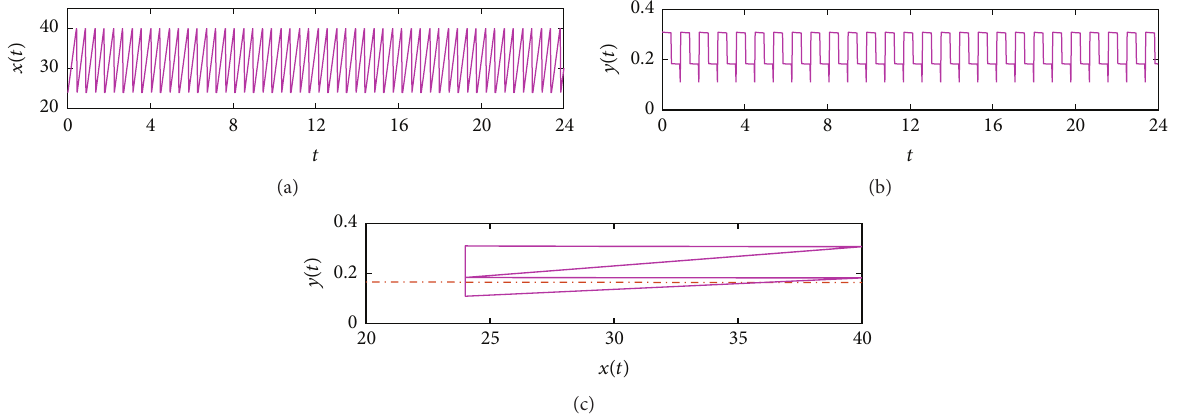
Figure 5: The change in prey density (a), predator density (b), and phase diagrams (c) starting from (𝑥 0 , 𝑦 0 ) = (24,0.25) with 𝑝 = 0.4 , 𝑞 = 0.4 , = 20 , ℎ = 40 , 𝑦 (ℎ ) = 0.1664 , 𝑦 ((1 − 𝑝)ℎ ) = 0.1651 , and 𝛼 ℎ 1 2 𝜏 1 𝜏 2